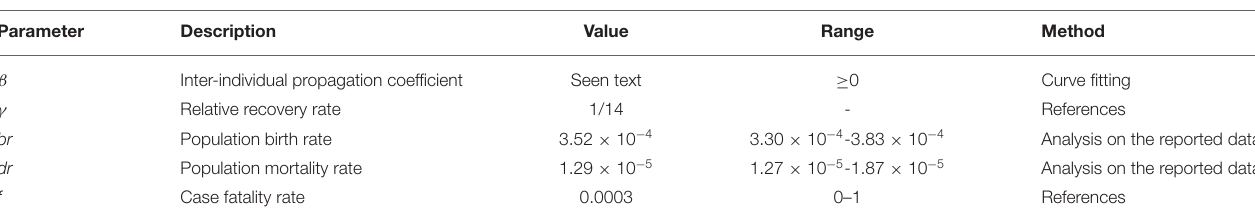
FIGURE 2 | The cross-age groups Susceptive-Infected-Recovered model. TABLE 1 | Parameter